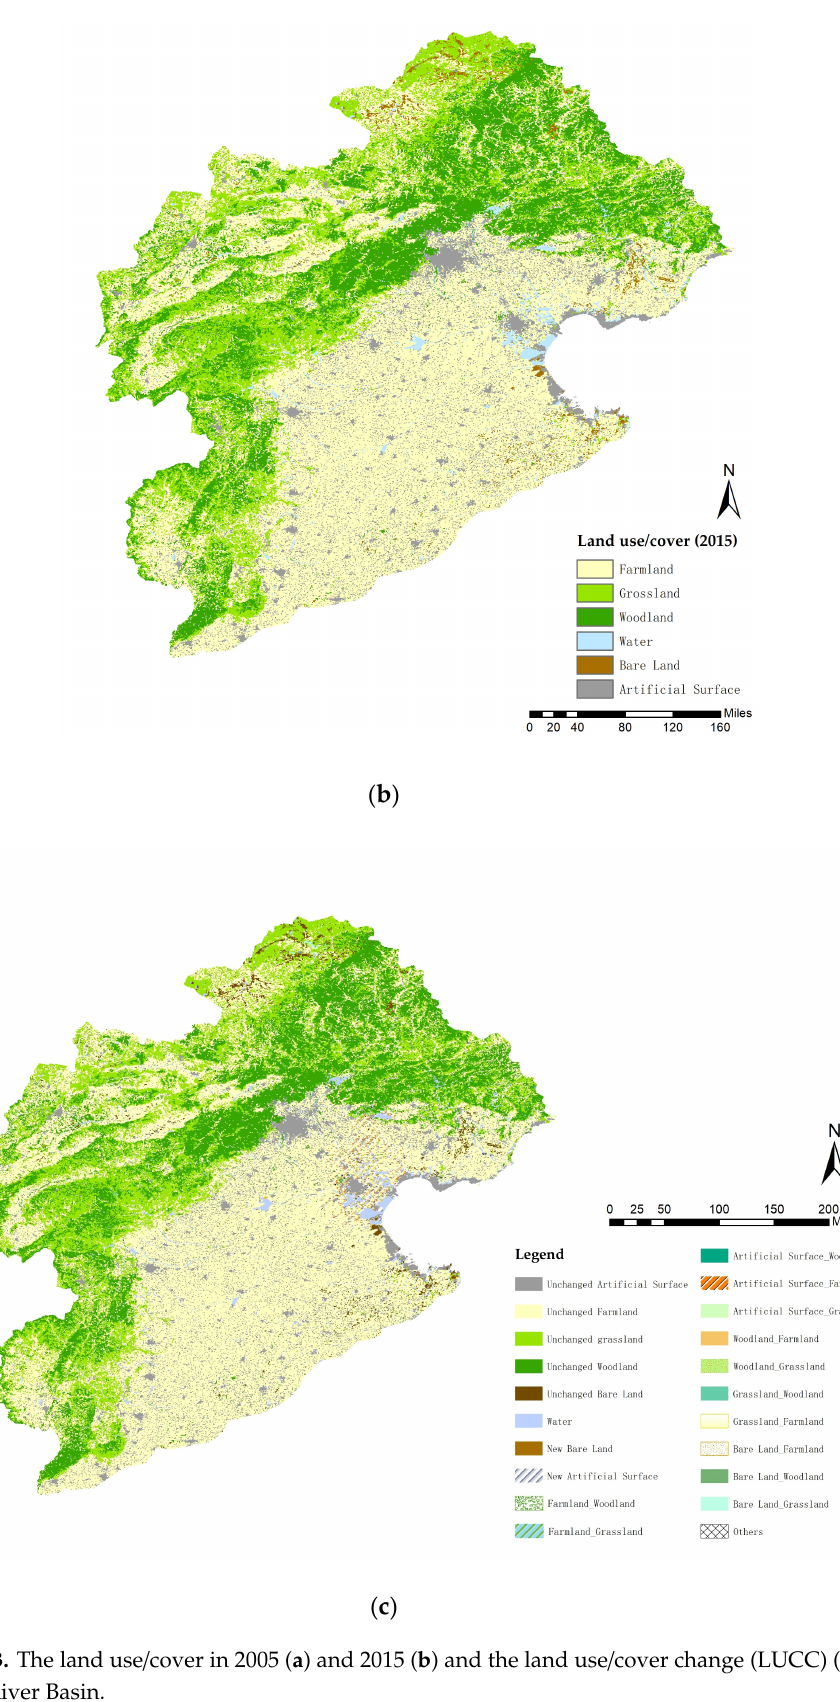
Figure 3. The land use / cover in 2005 ( a ) and 2015 ( b ) and the land use / cover change (LUCC) ( c ) in the Haihe River